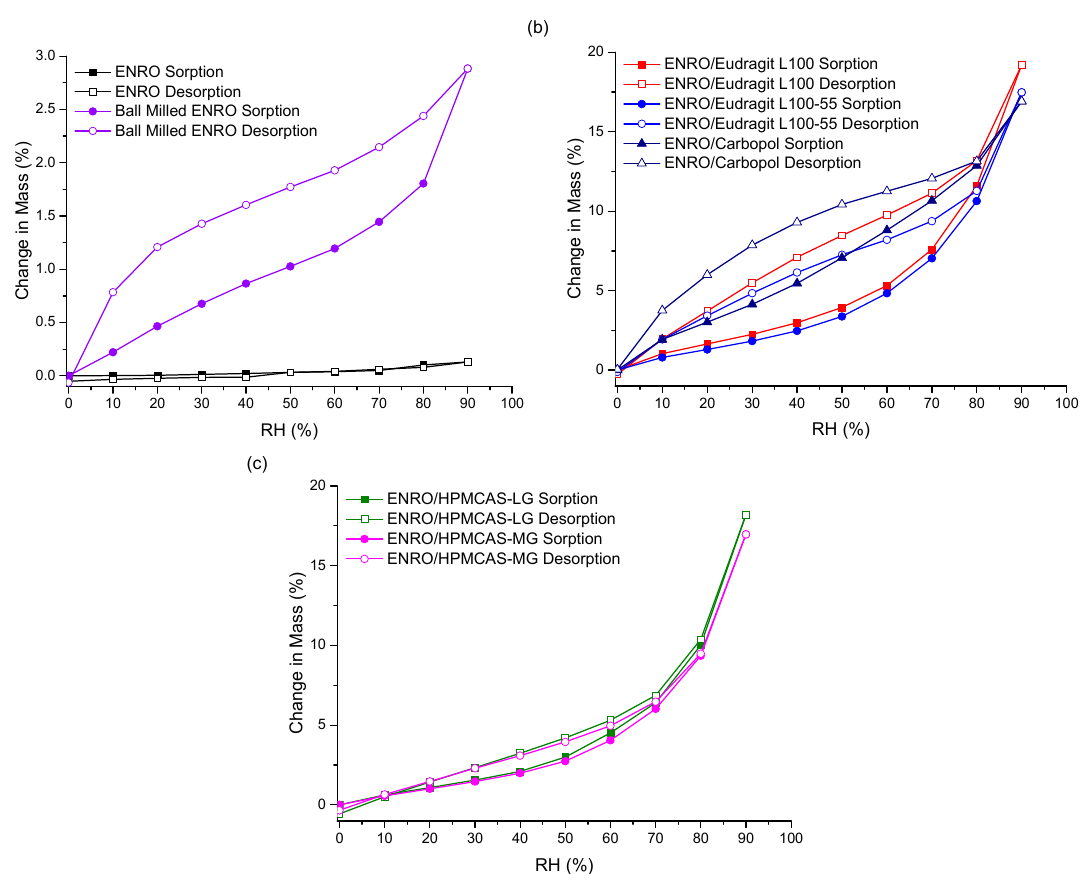
Figure 6. DVS isotherms of ( a ) crystalline and ball milled ENRO, ( b ) ENRO ASDs containing 40% ( w / w ) Eudragit L100, Eudragit L100-55, and Carbopol, and ( c ) ENRO ASDs containing 60% ( w / w ) HPMCAS-LG and HPMCAS-MG.